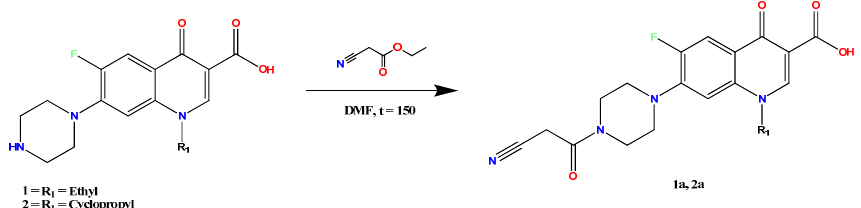
Figure 2. Synthesis of 7-(4-(2-cyanoacetyl)piperazin-1-yl)-1-R-6-fluoro-4-oxo-1,4-dihydroquinoline-3-carboxylic acids 1a, 2a.